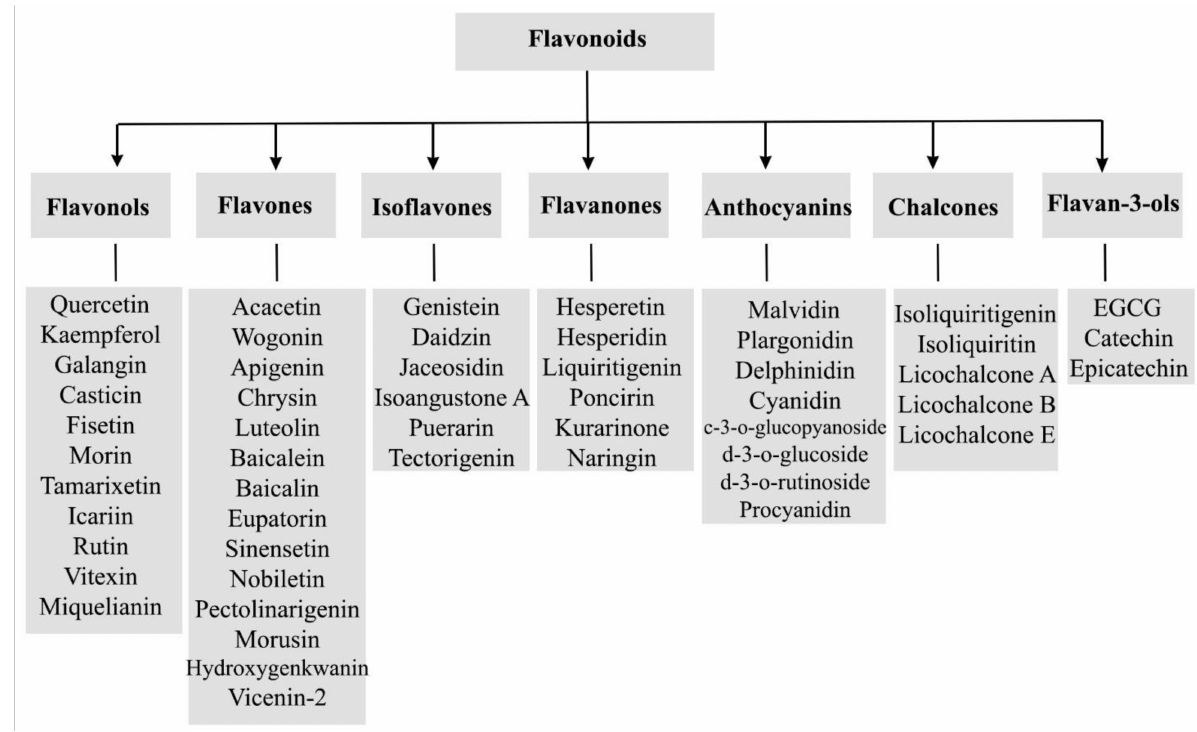
Figure 1. A general scheme of the classification of